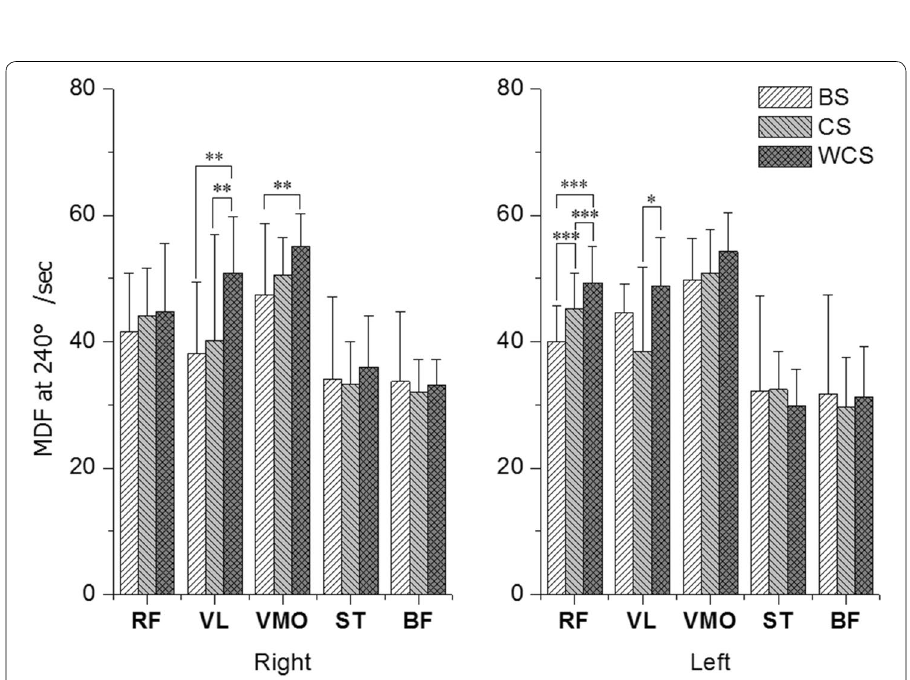
Fig. 11 MDF at the angular velocity of 240°/s: left is for the data of left leg; right is for the right